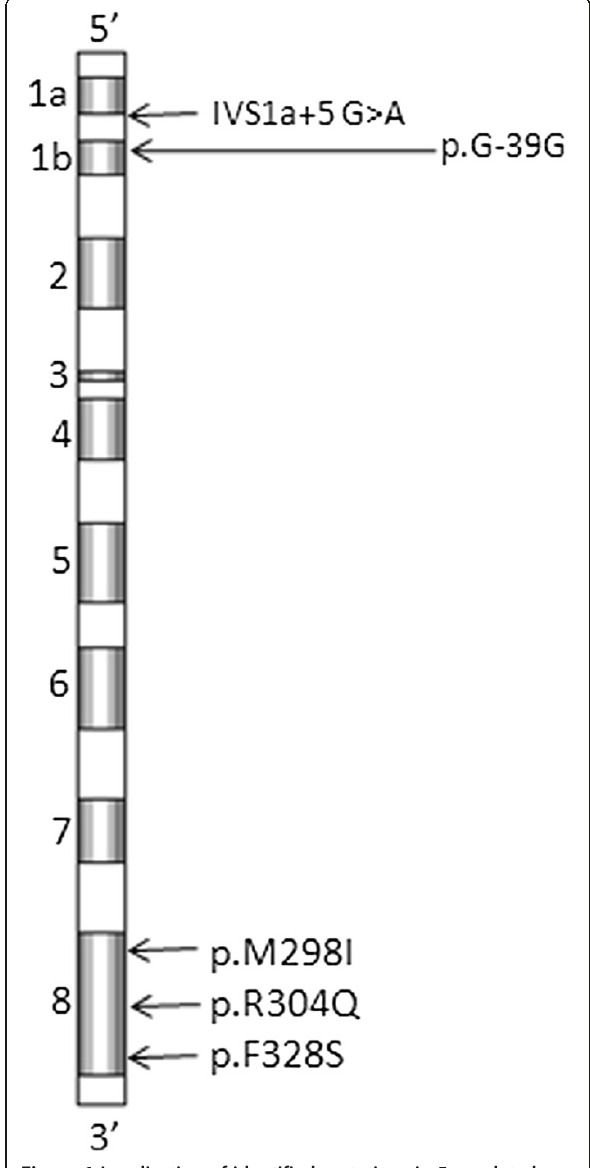
Figure 1 Localization of identified mutations in 5 unrelated Tunisian patients with FVII deficiency. The 3 punctual mutations are localized in the catalytic region within exon 8. The 2 splice mutations are localized in intron 1 and in the exon 2. Nucleotide numbers are based on the full sequence published by O ’ hara et al 1987 using the A of the ATG initiator methionine as +1. Numbering of the amino acids is based on Genebank file NM-000131. Methionine is numbered as −